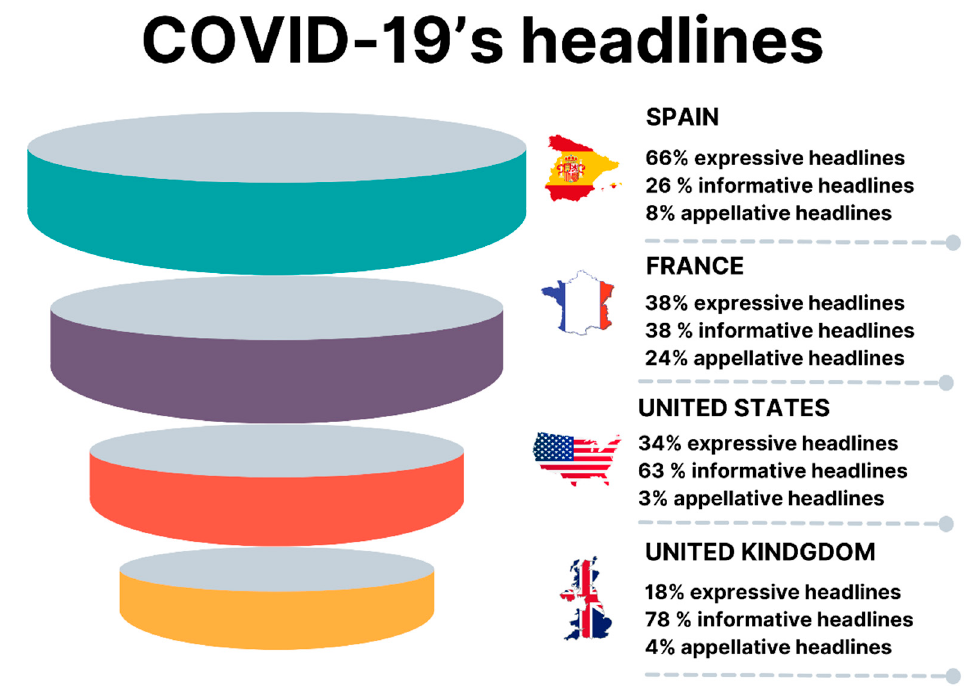
Figure 10. Analysis of COVID-19’s headlines.